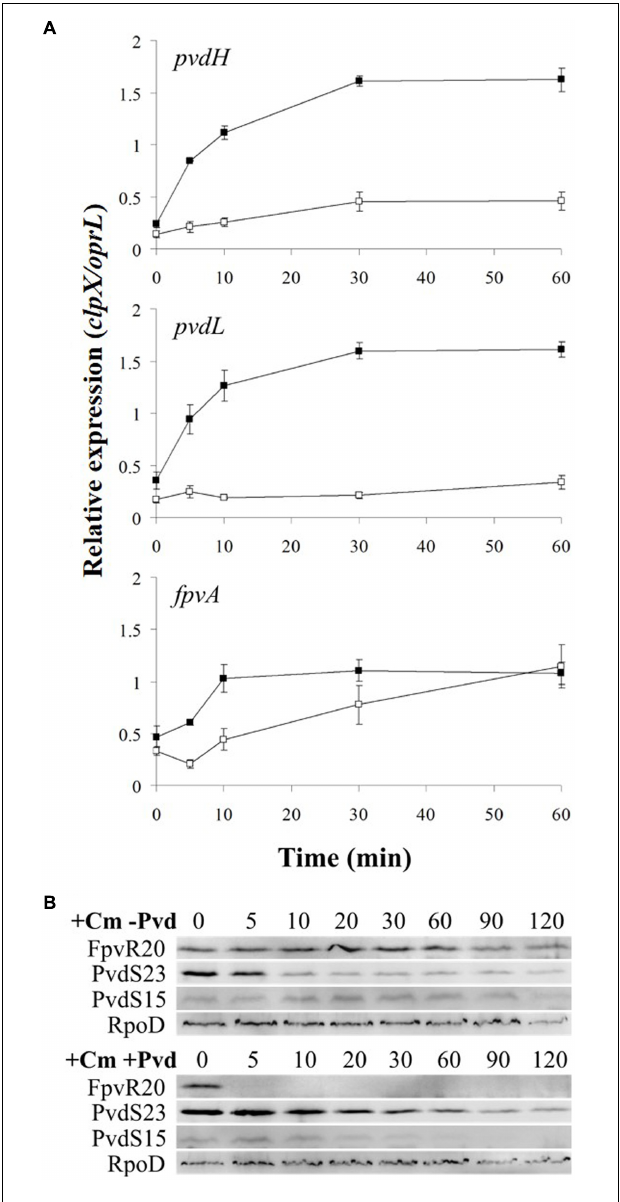
FIGURE 6 | Effect of chloramphenicol on induction of gene expression. Chloramphenicol (Cm) and then pyoverdine were added to P. aeruginosa PAO1 pvdF bacteria (0 min) and samples were collected at intervals. (A) Samples were analyzed by RT-qPCR for pvdH , pvdL , and fpvA . Open squares, Cm present; Black squares, Cm absent. Data are means of six technical replicates with standard deviation shown. (B) Samples were analyzed by Western blotting for σ PvdS or FpvR 20 in the presence or absence of pyoverdine, as shown. FpvR 20 , σ PvdS (full-size), PvdS 15 and RpoD are indicated. Times are shown in minutes. Similar results were obtained when the experiment was repeated (Supplementary Figure